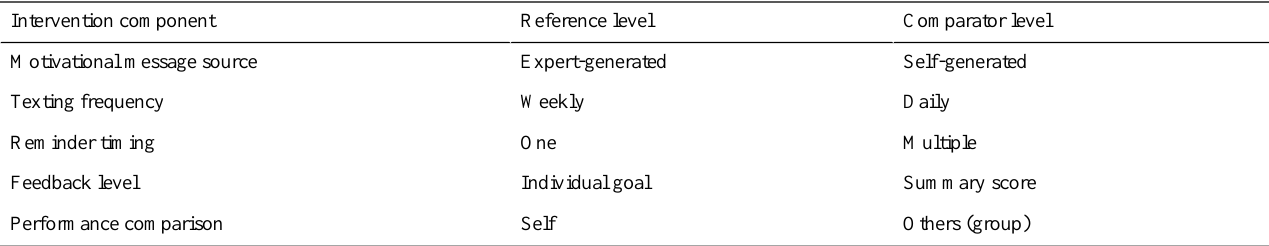
Table 1. Reference and comparator levels for intervention components.